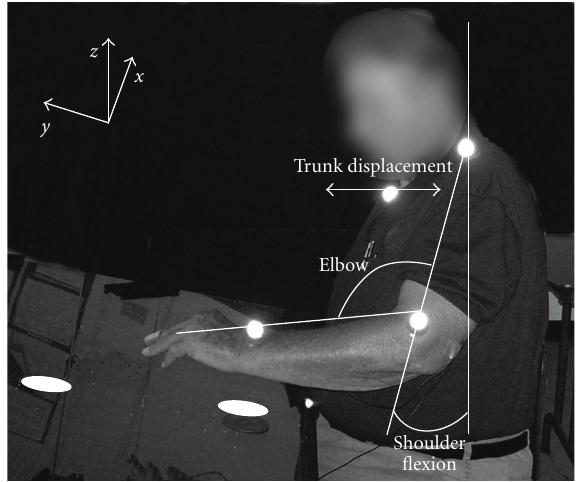
Figure 1: Experimental setup. Seated individuals reached with the stroke-a ff ected arm between a proximal target and a distal target placed at maximum reach of the stroke-a ff ected arm in a sagittal plane. Participants were instructed to tap back and forth as fast as they could, alternating between proximal and distal targets.